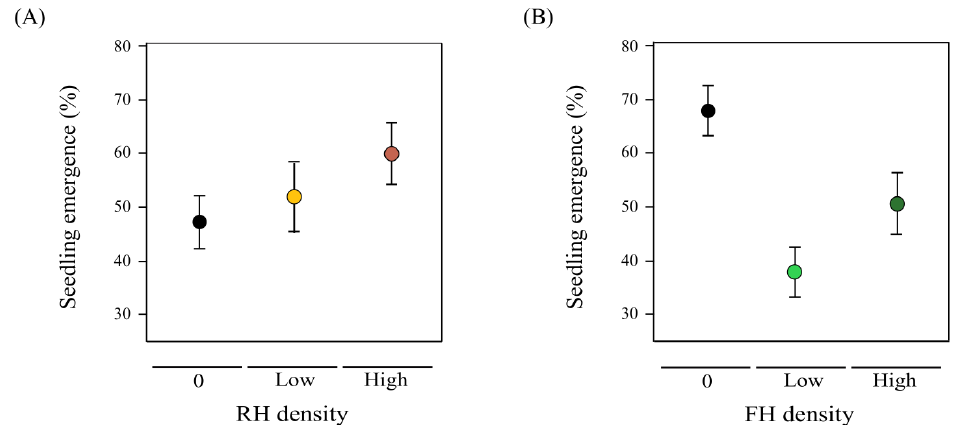
Figure 5. ( A ) Maternal root herbivore (RH) density effect on seedling emergence. Black points are shown for 0 RH density (RH 0 plants, absence of RH), orange points are shown for low RH density (RH 1 plants, one RH individual), red points are shown for high RH density (RH 2 plants, two RH individuals). ( B ) Maternal floral herbivore (FH) density effect on seedling emergence. Black points are shown for 0 FH density (FH 0 plants, absence of FH), light green points are shown for low FH density (FH 1 plants, one FH individual), dark green points are shown for high FH density (FH 2 plants, two FH individuals).